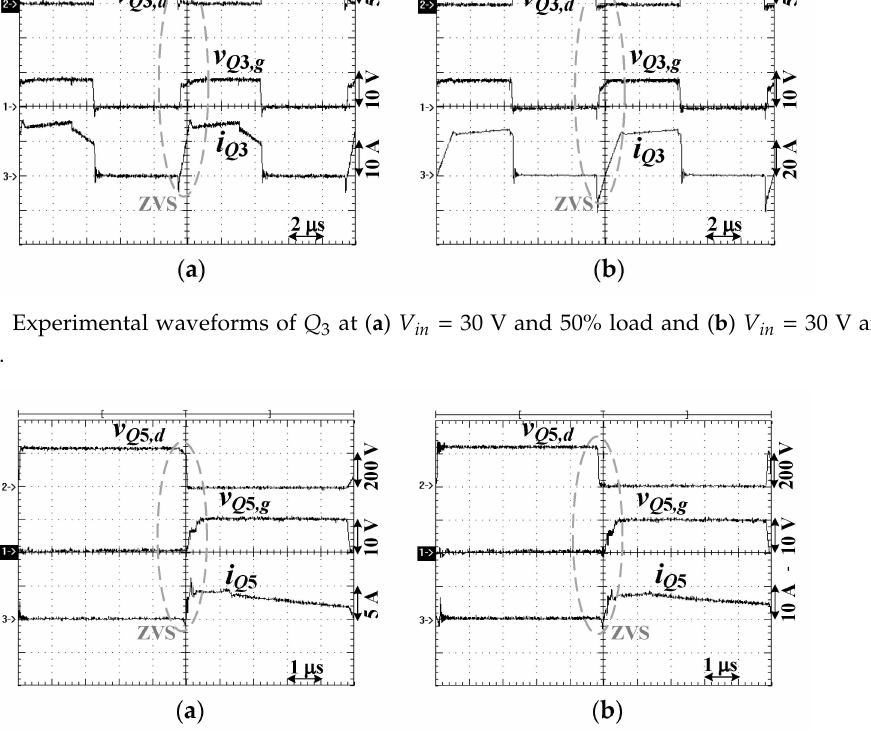
Figure 12. Experimental waveforms of Q 5 at ( a ) V in = 240 V and 50% load and ( b ) V in = 240 V and 100%